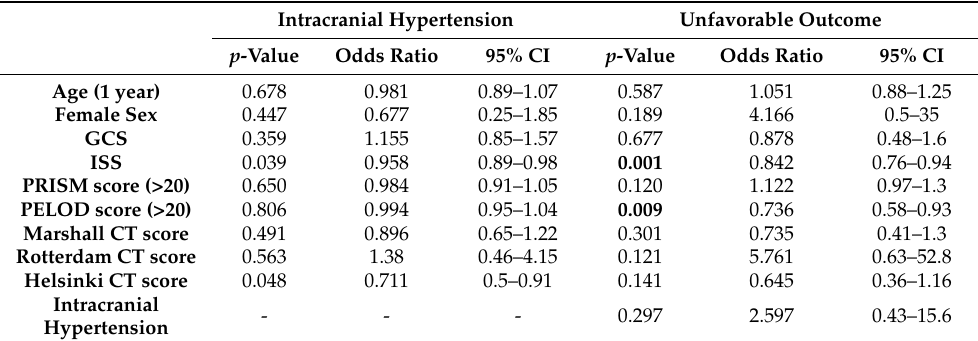
Table 3. Multivariate linear regression of potential predictors related to IC-HTN and unfavorable outcome for sTBI pediatric patients.